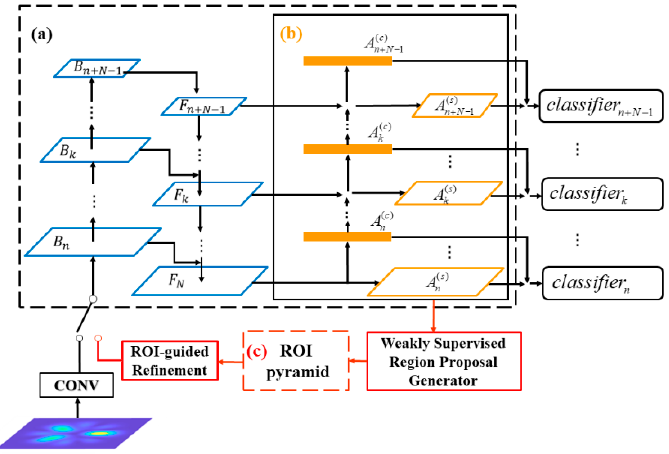
Figure 1. Structure of the AP-CNN for OAM mode recognition. ( a ) dual-path algorithm structure, ( b ) attention pyramid, ( c ) ROI pyramid. ( b ) attention pyramid, ( c ) ROI